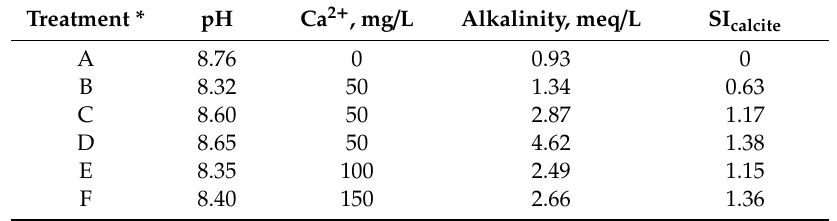
Table 2. Initial conditions for precipitation experiment, showing the di ff erent Treatments A–F. Treatment * pH Ca 2 + , mg / L Alkalinity, meq / L SI calcite